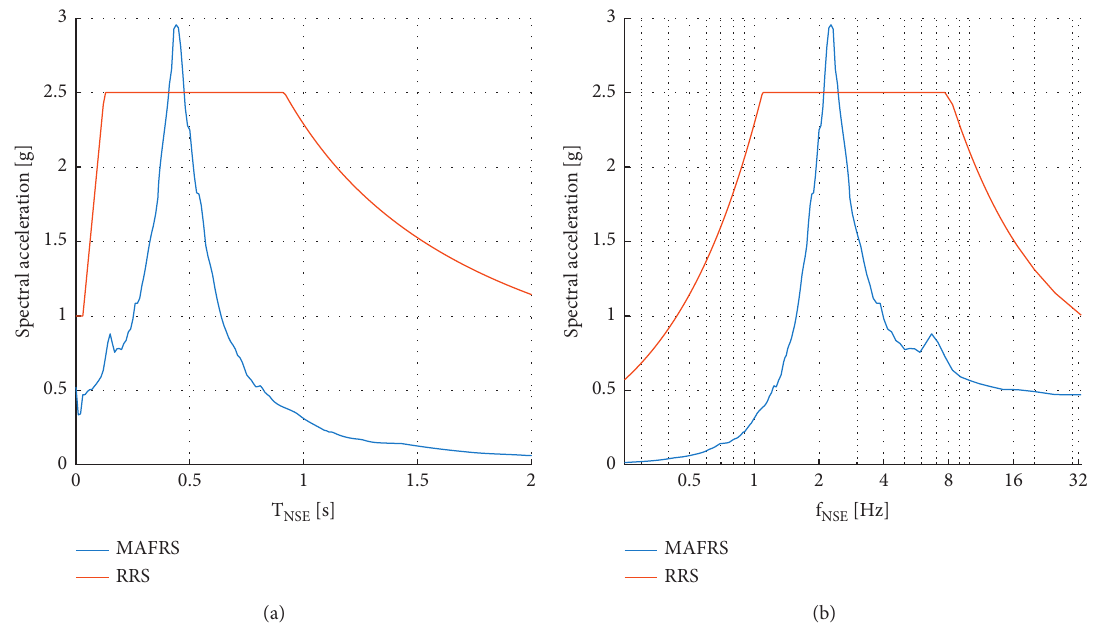
Figure 12: Comparison between MAFRS and “Qualification Spectrum”: (a) acceleration-period and (b) acceleration-frequency